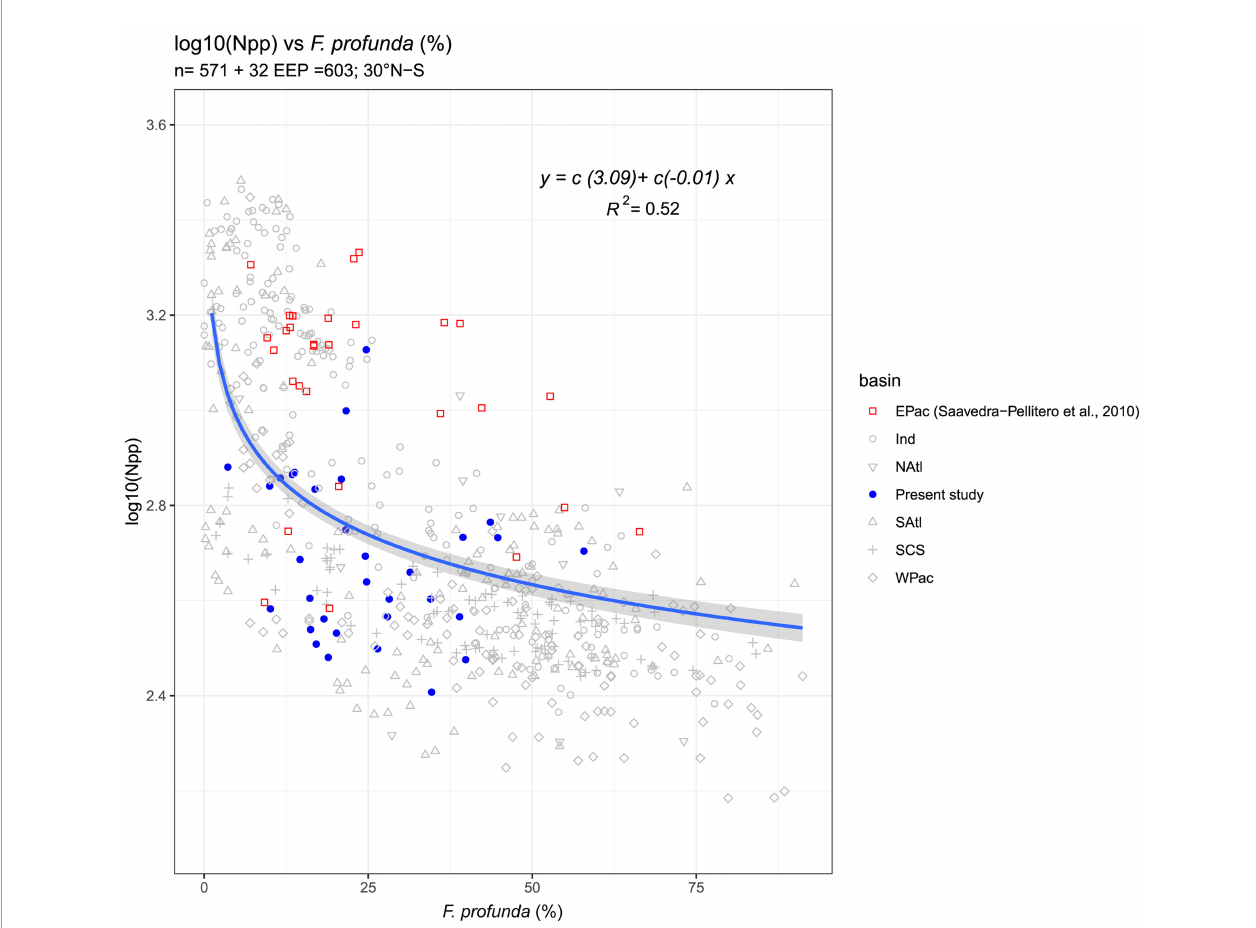
FIGURE 7 | Regression between relative abundance of Florisphaera profunda in surface sediments located between 30°N-30°S in different basins across the World ’ s oceans and NPP (in mg C m -2 day -1 ) from VGPM estimates for the same locations (Herna ́ ndez-Almeida et al., 2019) indicated with a blue line. The regression includes samples from Saavedra-Pellitero et al. (2010) located in the Eastern Paci fi c (EPac, indicated with red squares). The blue dots represent the F. profunda- NPP relationship for the new surface sediment samples from this study, located in the Eastern Equatorial Paci fi c and the grey shaded area shows the residual standard error